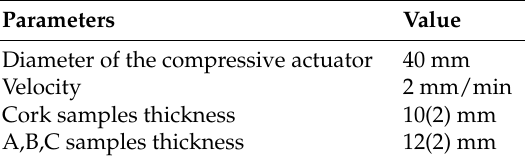
Table 5. Quasi-static test parameters.